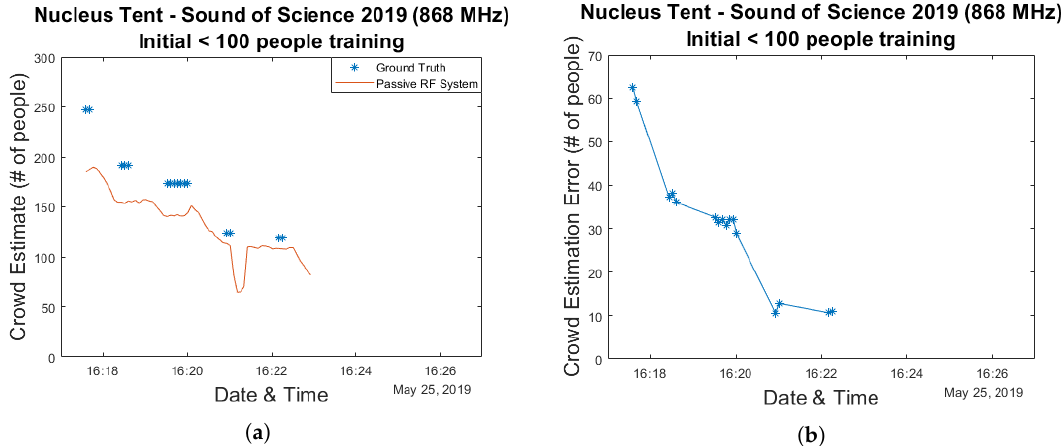
Figure 18. A crowd estimation graph and its corresponding error graph for a model trained using the data from the Sound of Science experiments for which the actual number of people present was below 100 and evaluated based on all remaining data. ( a ) shows the crowd estimation graph and ( b ) shows the error graph.